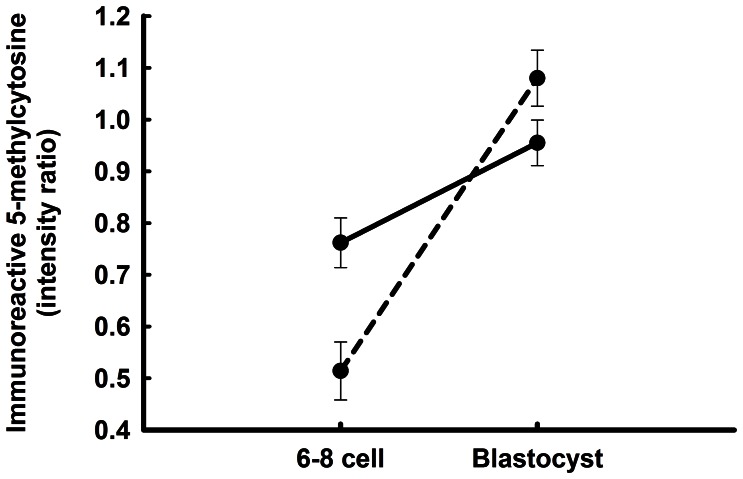
Effects of gender on immunoreactive 5-methylcytosine in embryos at the 6–8 cell and blastocyst stages of development.Data represent the ratio of fluorescent intensity for anti-5-methylcytosine to that for propidium iodide. The solid line represents female embryos while the hashed line represents male embryos. Data are least-squares means±SEM of results from 11–21 embryos per stage. Amounts of DNA methylation were affected by gender (P = 0.0029), stage of development (P<0.0001) and the stage × gender interaction (P = 0.0007).